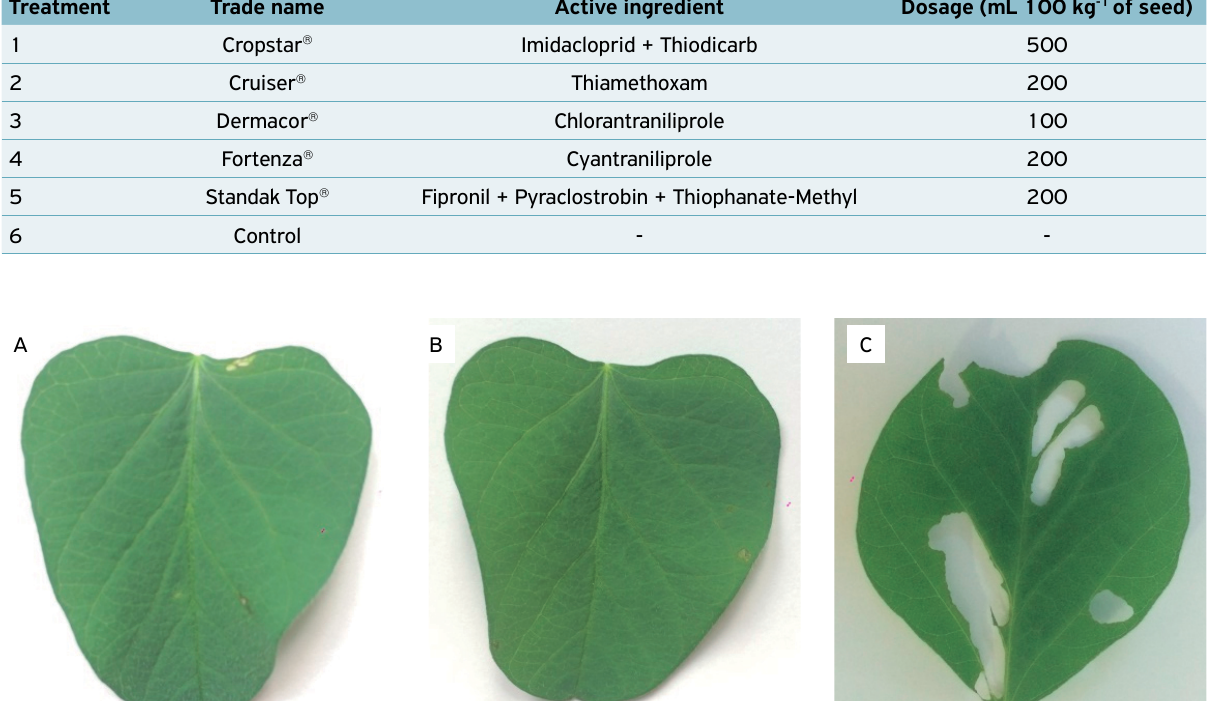
Table 1. Characterization of the insecticides and their respective dosages used in the seed treatment. Treatment